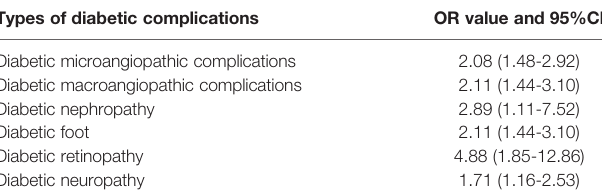
TABLE 2 | The OR values and 95%CI of diabetic